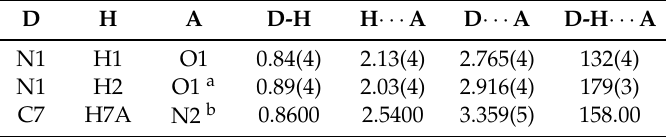
Table 3. Hydrogen bonding data for compound 4 .